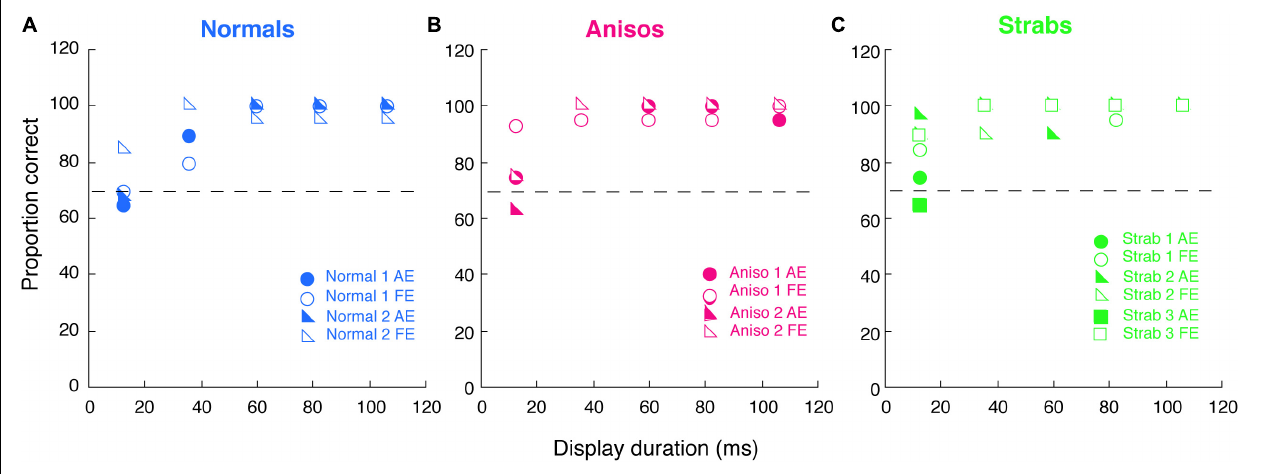
FIGURE 6 | Proportion correct of a single target orientation discrimination as a function of the target display duration for 2 Normals (A) , 2 Anisos (B) , and 3 Strabs (C) , who also participated in Experiment 2. Open symbols, dom/fellow eye; filled symbols, nondom/amblyopic eye. Horizontal dashed lines indicate 75%